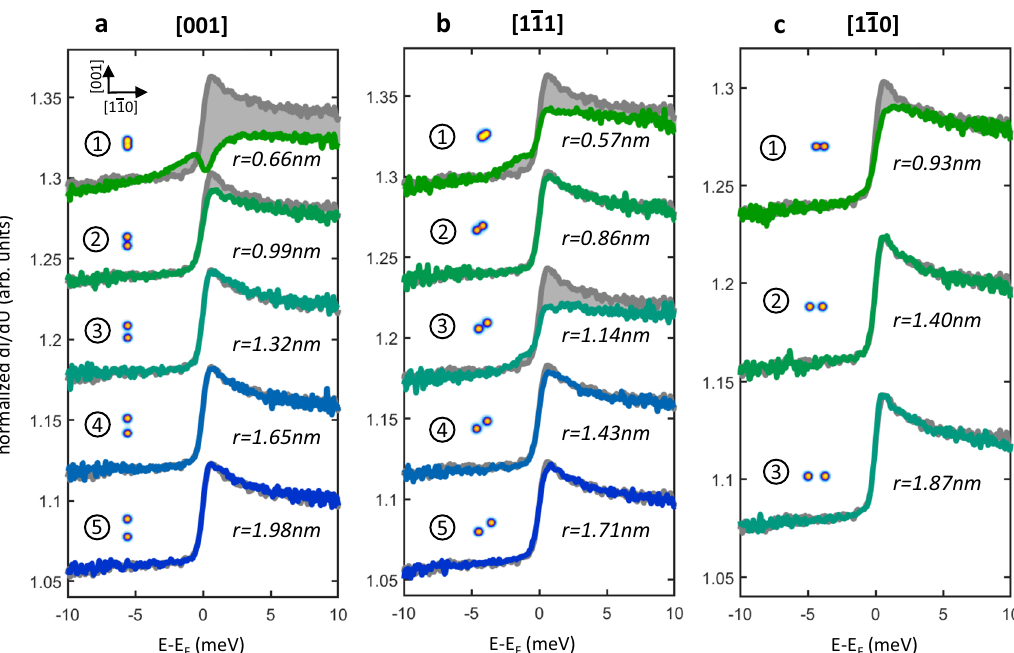
Fig. 4 Spectroscopy in the metallic regime. a – c dI/dU signals over atom A with increas- ing distance of atom B starting with step 1 at next-nearest- neighbor positions for three different crystallographic directions. The signal of the isolated Cr adatom is shown in gray for each spectrum as a reference. An external out of plane magnetic fi eld of 1 T was applied to fully suppress superconductivity. Stabilization parameters: − 10 mV; 3 nA. Insets: topographic images of the corresponding dimer shown in equal